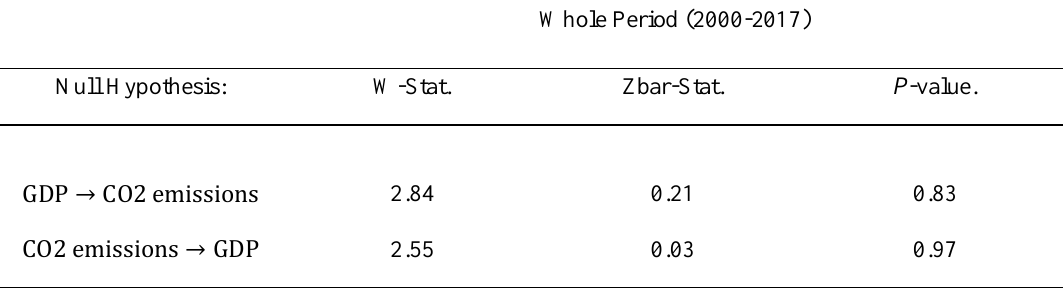
Table 2: Pairwise Dumitrescu-Hurlin (2012) Panel Causality Test Whole Period (2000-2017) W-Stat.